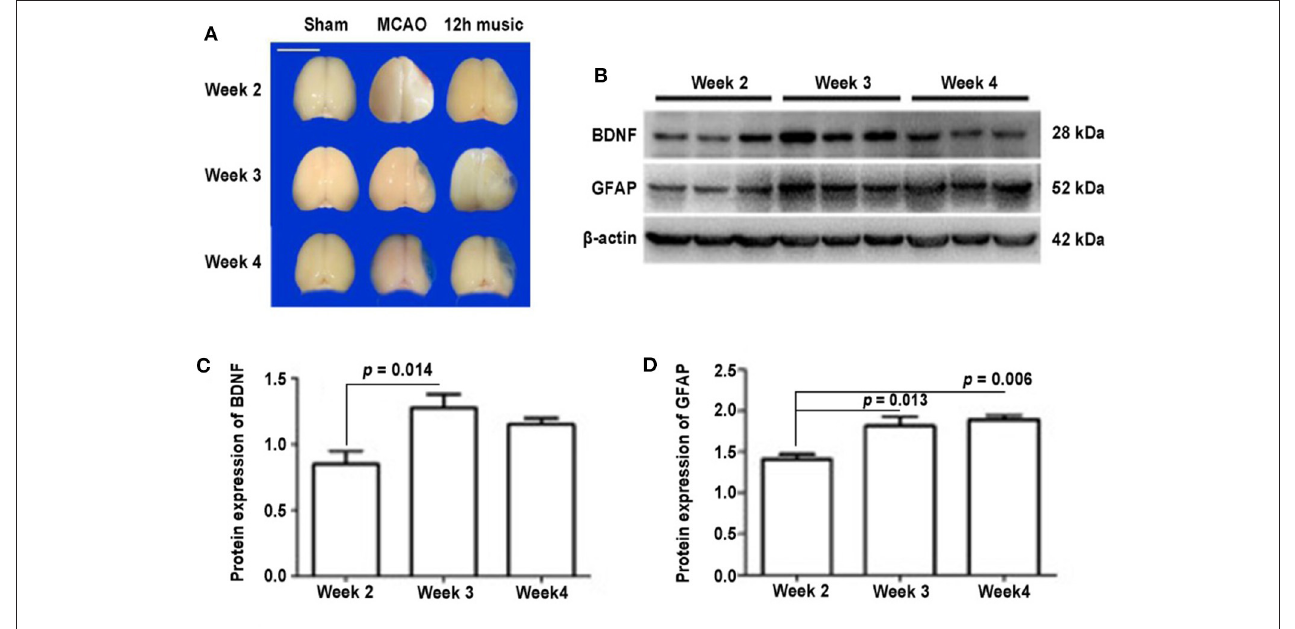
FIGURE 5 | Effects of 12h music therapy on brain morphology and the expression of BDNF and GFAP at 2, 3, and 4 weeks after MCAO. (A) Brains of sham, MCAO, and 12h music groups at 2, 3, and 4 weeks after MCAO. Bar, 1cm. (B) Western blot analysis of BDNF and GFAP in the lesioned area of the 12-h music group.